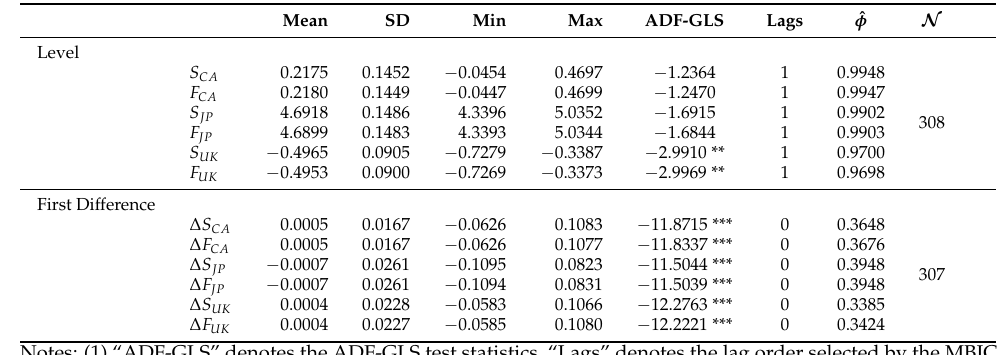
Table 1. Descriptive Statistics and Unit Root